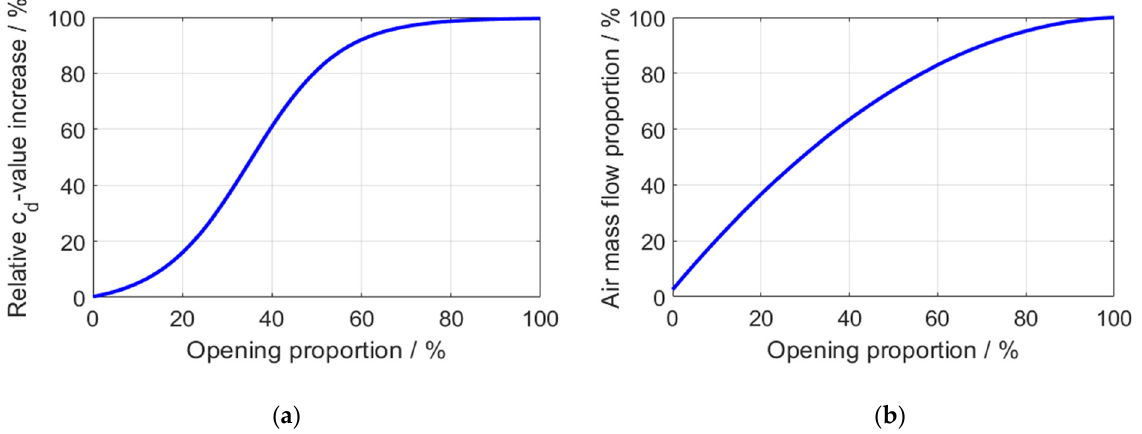
Figure 5. Shutter modelling regarding: ( a ) relative drag coefficient increase as in equation (21); ( b ) relative air mass flow to radiator.